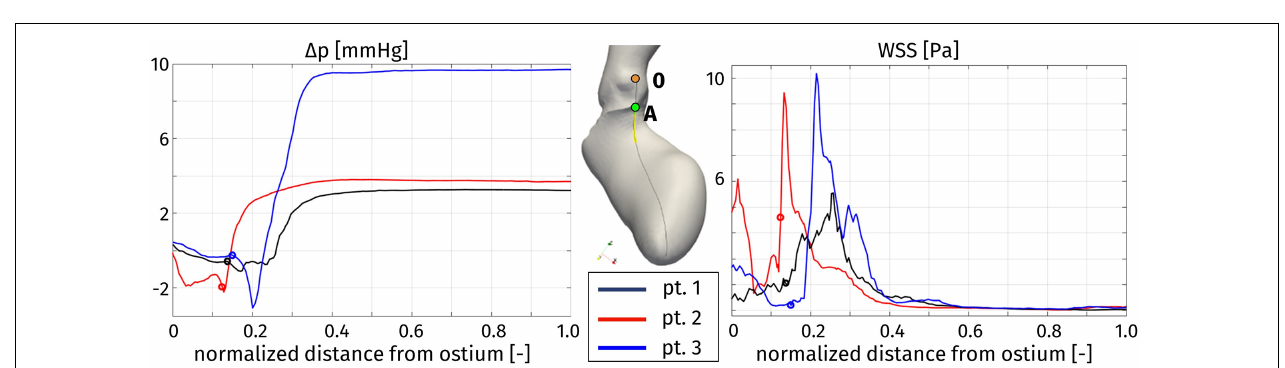
FIGURE 9 | Distribution of pressure difference (cid:49) p = p-p out on a longitudinal slice, at significant times during systole.